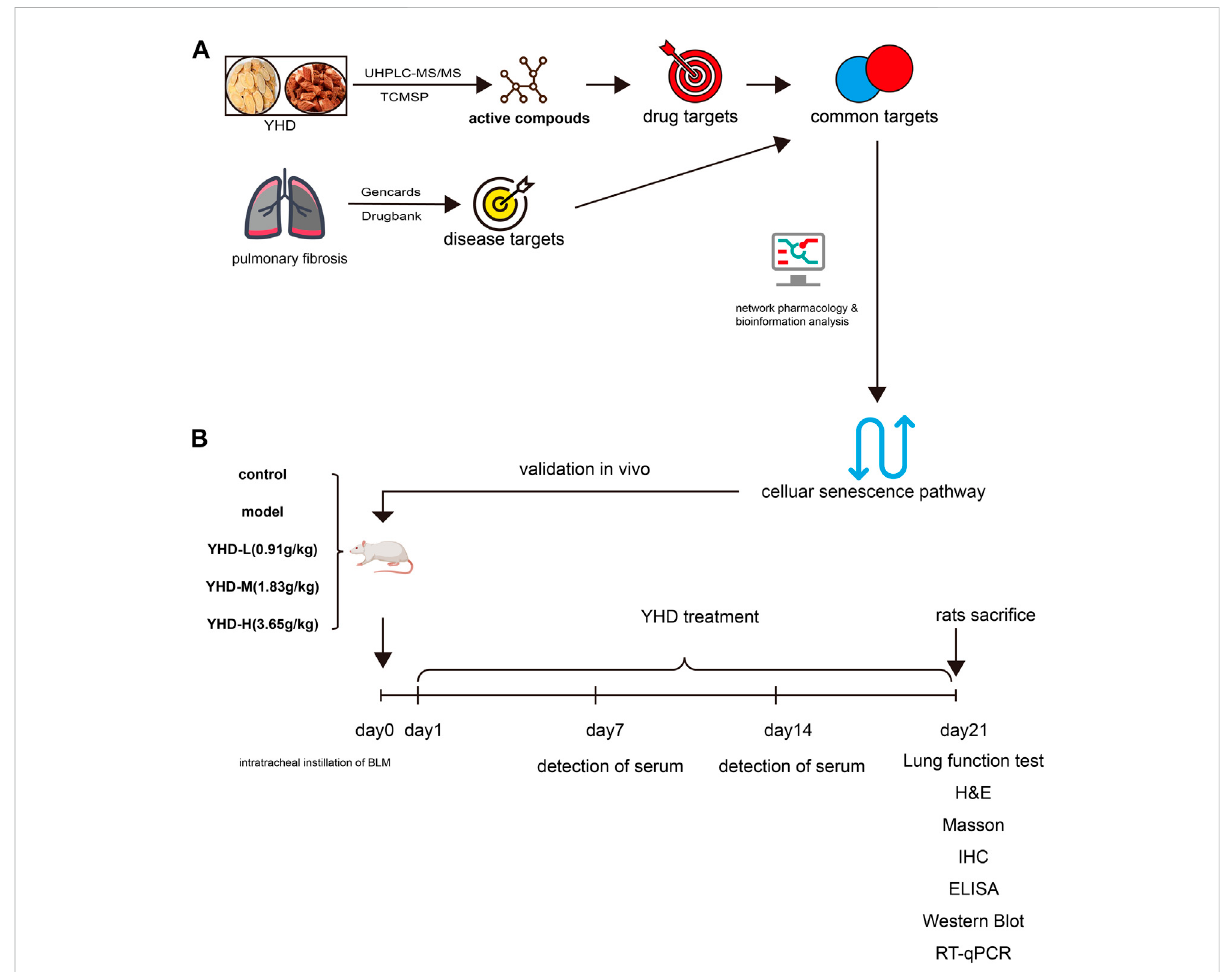
FIGURE 1 Experimental fl ow diagram. (A) Network pharmacology (B) Animal experiment. Pulmonary fi brosis was induced in rats by tracheal drops of bleomycin at day 0. From day 1 to day 21, rats were given YHD by gavage once a day, and orbital blood was collected from rats once a week. Each group of rats ended up with at least 6 biological